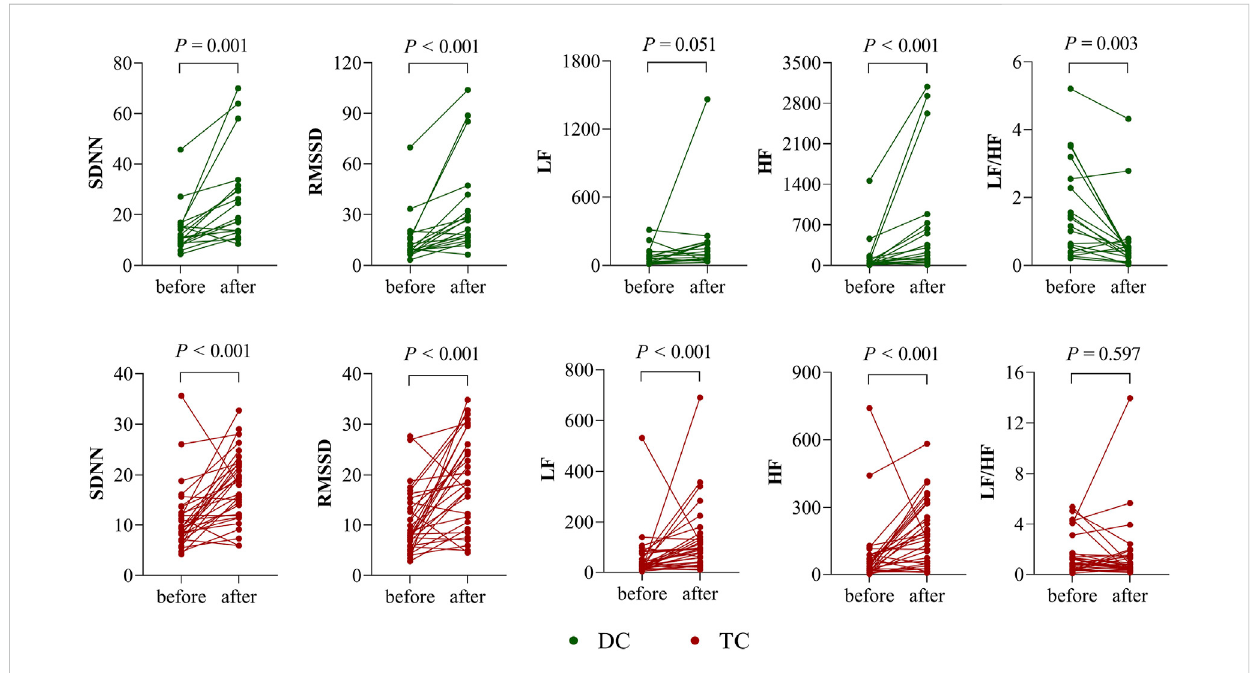
FIGURE 1 Differences in HRV before and after chemotherapy in the DC and TC groups.